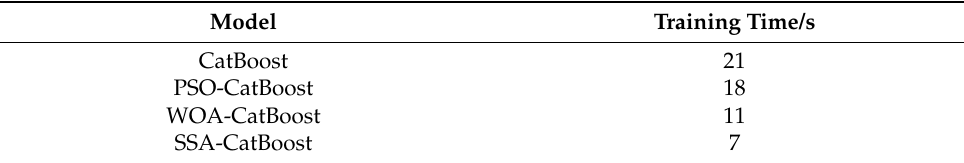
Figure 10. Evaluation comparison of different models. Table 11. The training time of different optimized models.